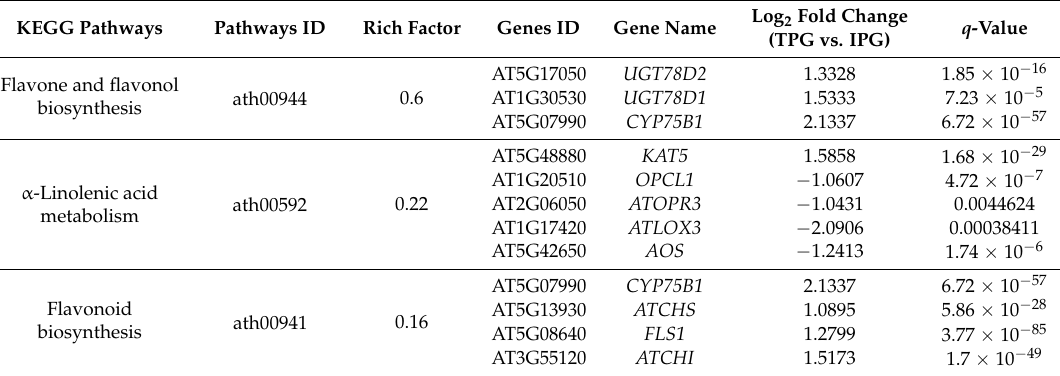
Table 2. The DEGs involved in three KEGG pathways with the highest rich factor